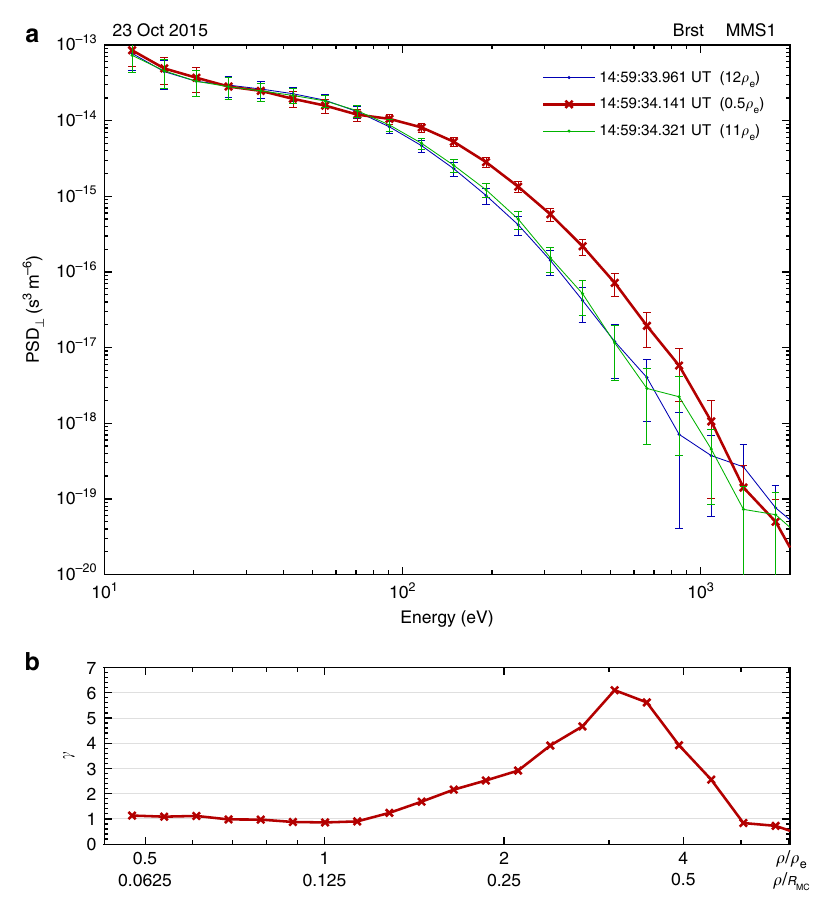
Fig. 4 The energy spectra of electron PSD ⊥ observed inside and outside the ESMC. PSD ⊥ is averaged over 360° in the plane perpendicular to the magnetic fi eld. In panel a , the x -axis is the electron energy, and the y -axis is the average PSD ⊥ (with error bars). The red line represents observations taken near the center of the ESMC, and the other two lines (blue and green) represent observations outside the structure. The time of measurement and the distance between the spacecraft and the center of ESMC are labeled in the top right corner. In panel b , the x -axis is the same as that in panel a , but the energy is reformulated in terms of electron gyro-radius ρ and normalized by the gyro-radius of the thermal electron ( ρ e ) or the radius of the magnetic cavity ( R MC ). γ is the ratio between the PSD ⊥ inside (red line in panel a ) and outside (blue and green lines in panel a ) the structure in each energy channel. The error bars in panel a are instrumental errors directly obtained from the FPI data